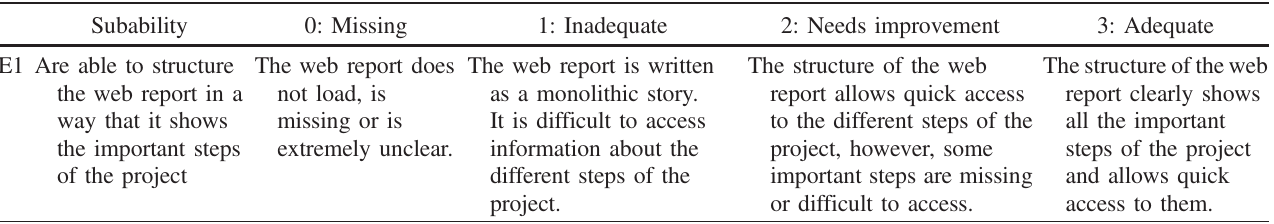
TABLE IV. The first line of the new rubric for the ability of writing a report in the form of a web page. Subability